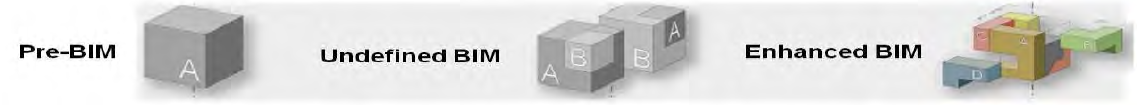
Figure 10. the revolutionary phases of model